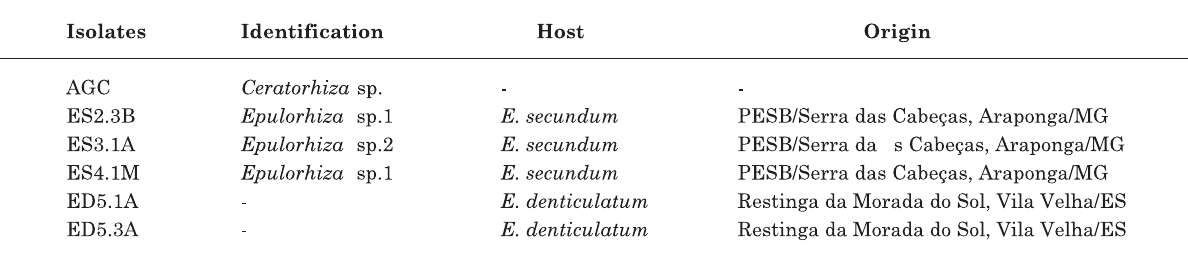
Table 1. Isolate codes, identification of fungal species, host species, and origin of the Rhizoctonia -like fungi